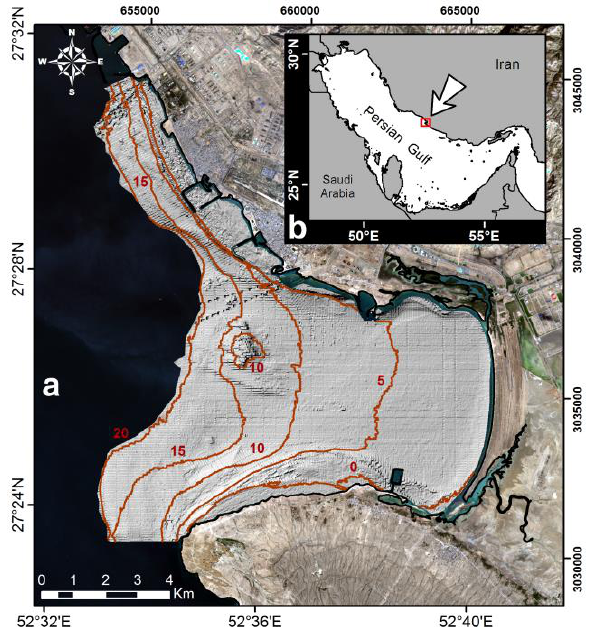
Figure 1. Bathymetric map of the study area (Nayband Bay), where XY refers to the UTM-Zone 39 (WGS-84) projection system (a). Location of Nayband Bay in the south of Iran (b)